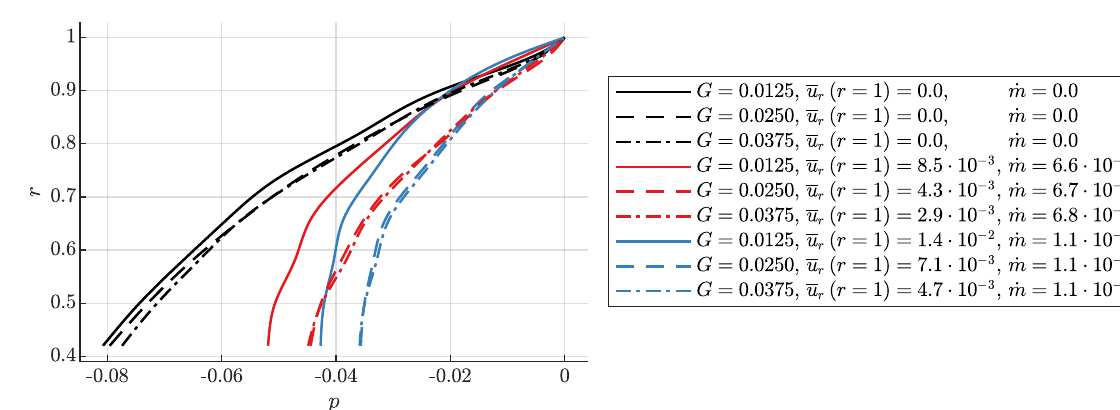
Figure 5. Cavity width influence on the radial pressure distribution at a high Reynolds number of Re = 2.5 · 10 8 with and without centrifugal through-flow. Experimental results.